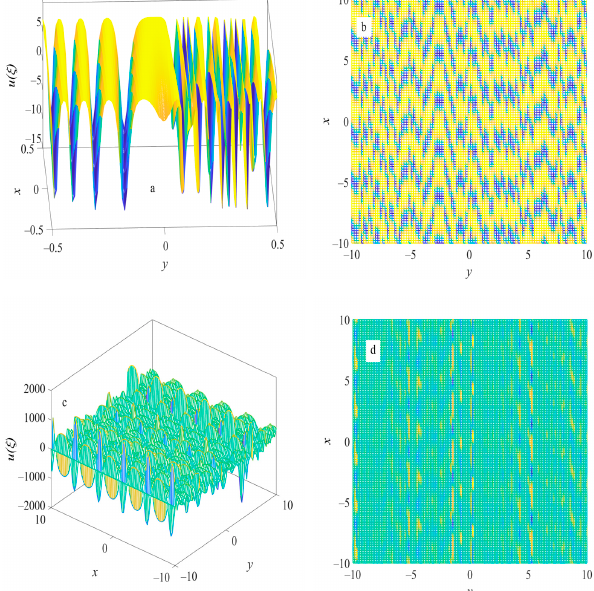
Figure 6. ( a ) Three-dimensional and ( b ) two-dimensional contour plots represent the chaotic wave structure of Equation (35) and ( c ) three-dimensional and ( d ) two-dimensional contour plots represent the chaotic wave structure of Equation (36) when 𝑘 = 2, 𝑚 = 0.6, 𝜆 = 1,𝑡 = 1 and 𝜔 = 14 .